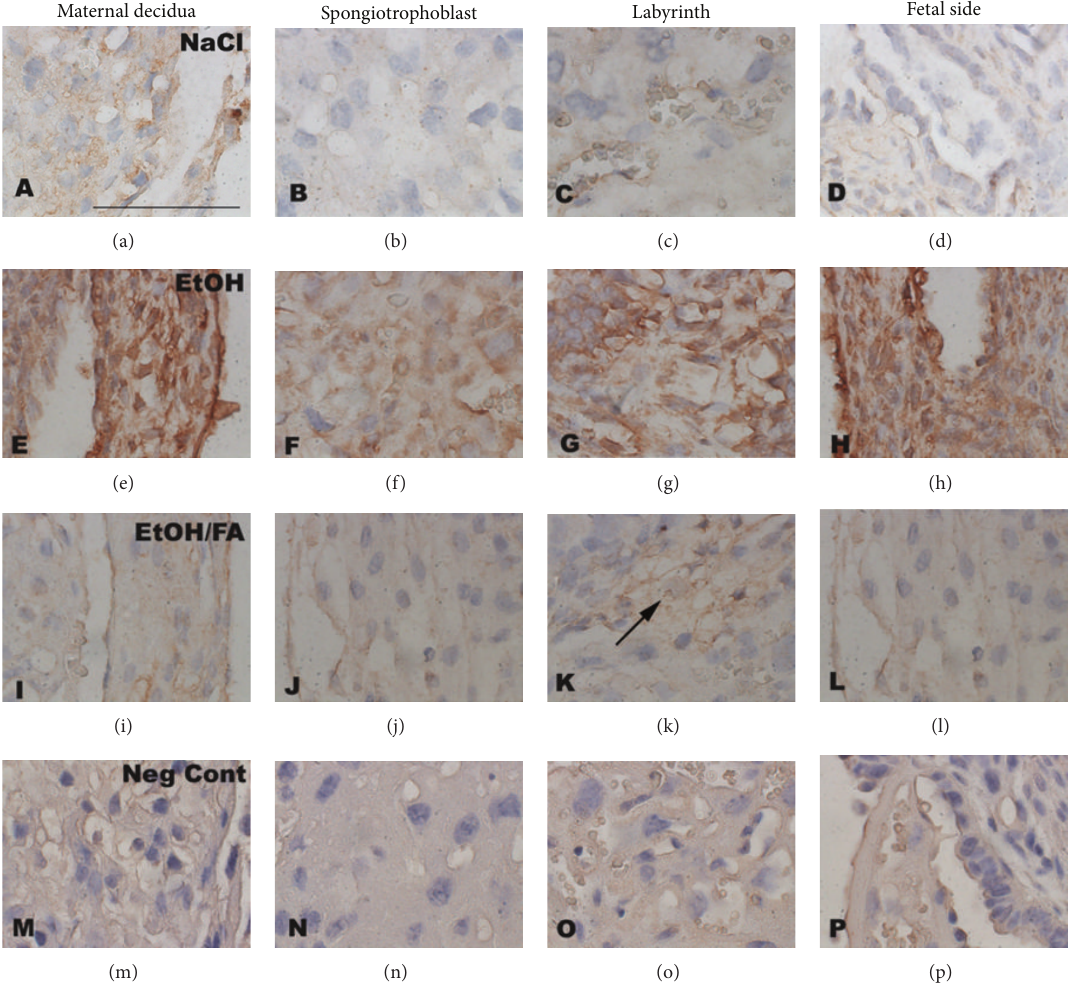
Figure 4: In comparison to placental cells of control embryo ((a)–(d)),oneexposureof embryos to a binge-level of alcohol during gastrulation resulted in an upregulation of NMHC-IIB in all cell populations of the placenta more than a week after exposure, as observed at mid-gestation (embryonic day 15.5; (e)–(h)). Folate supplementation prevents the upregulation and maintains normal protein expression ((i)–(l)). Negative control is shown in bottom row ((m)–(p)). Figure from Han et al., 2012